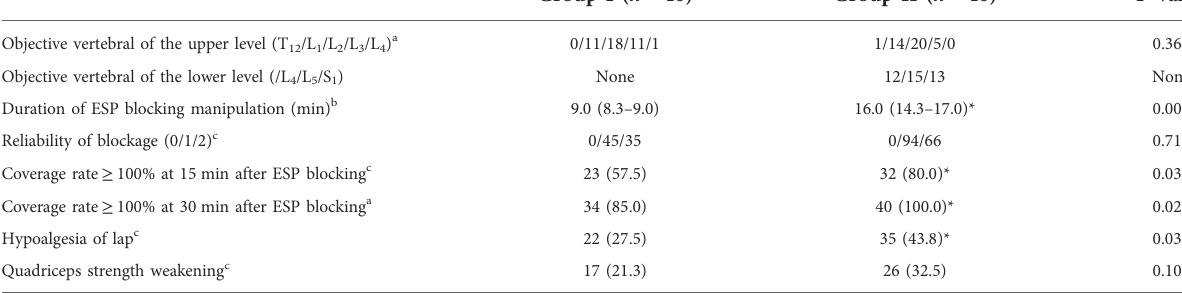
TABLE 2 Target vertebra of the block and block